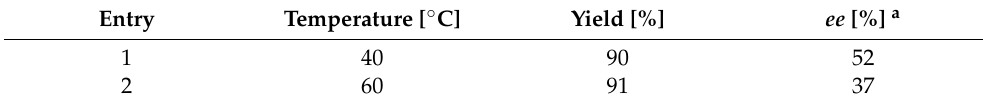
Table 3. Asymmetric MBH reactions at elevated temperatures.